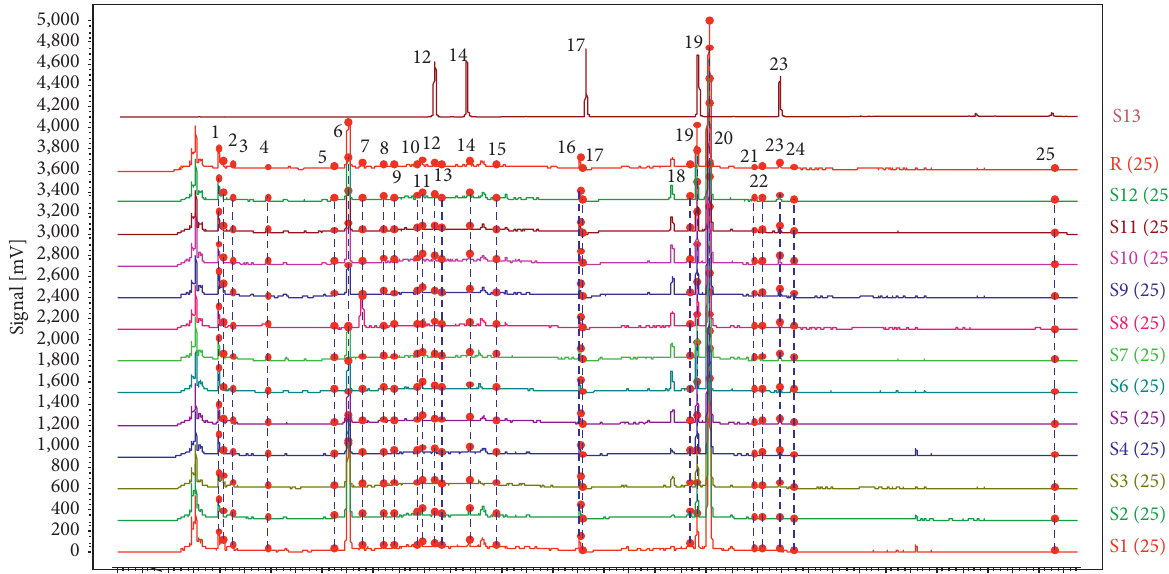
Figure 3: The fingerprints of 12 batches of TMOL, R reference fingerprint based on column switching technology, and (S13) the chromatogram of mixed reference standard solution. Peaks 12, 14, 17, 19, and 23 refer to syringin, chlorogenic acid, calycosin 7-O-glucoside, hesperidin, and icariin,